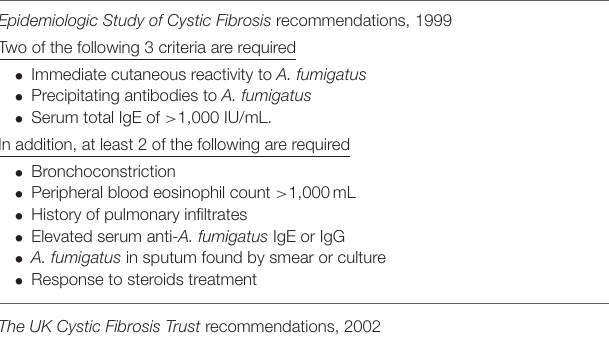
TABLE 2 | History of acceptable criteria for diagnosing